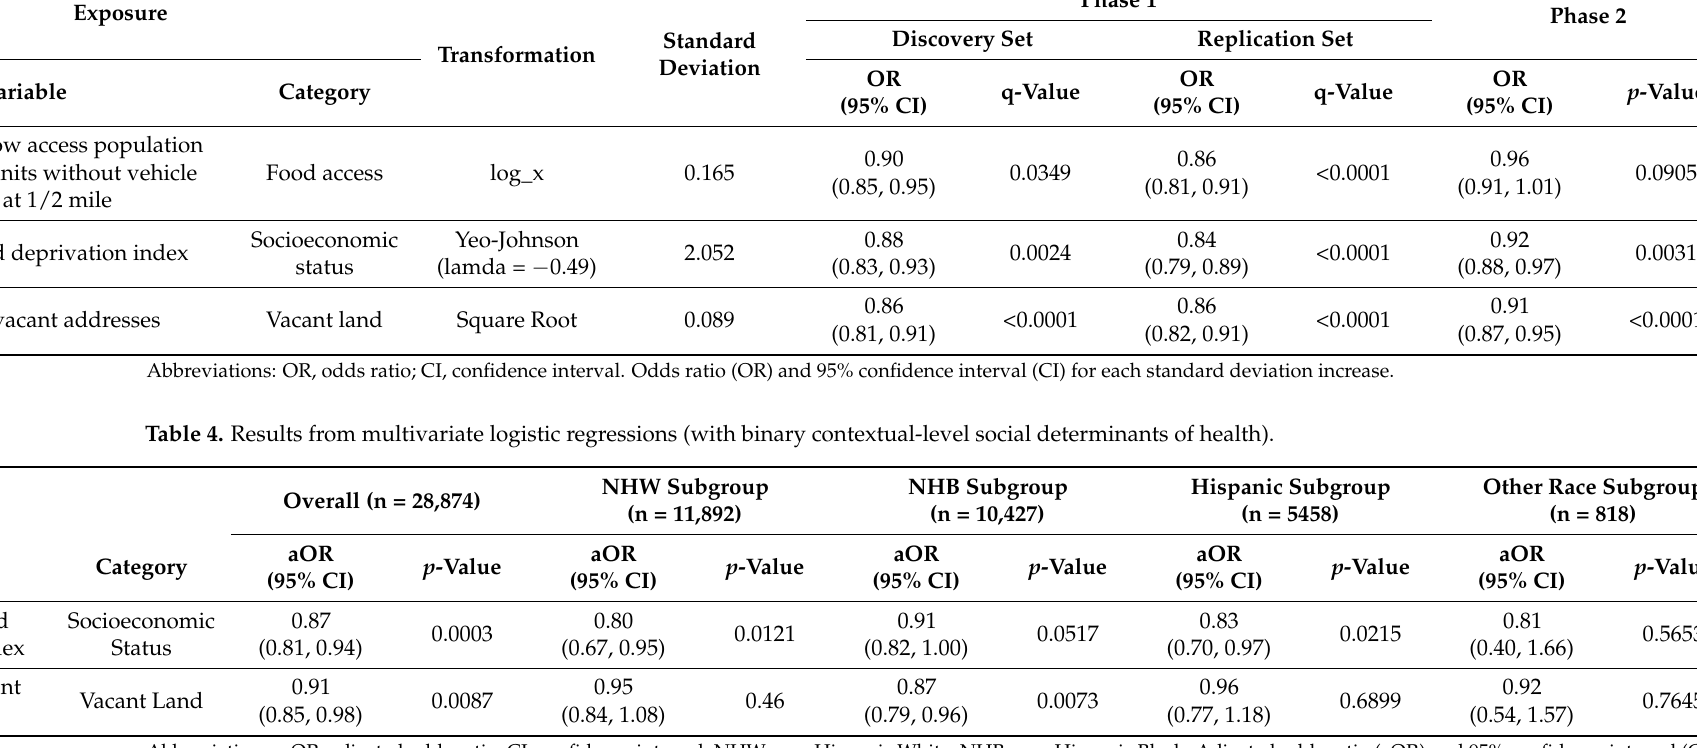
Phase 1 Discovery Set Replication Set Standard Transformation Deviation